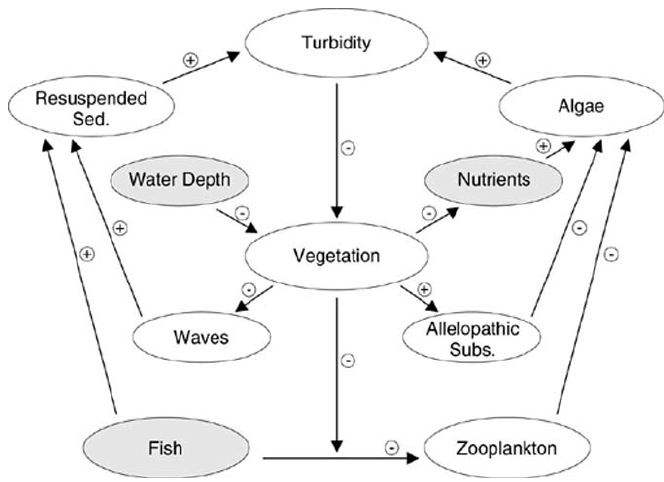
FIGURE 2. Feedbacks that may cause a vegetation dominated state and a turbid state to be alternative equilibria. The qualitative effect of each route in the diagram can be computed by multiplying the signs along the way. This shows that both the vegetated and the turbid state are